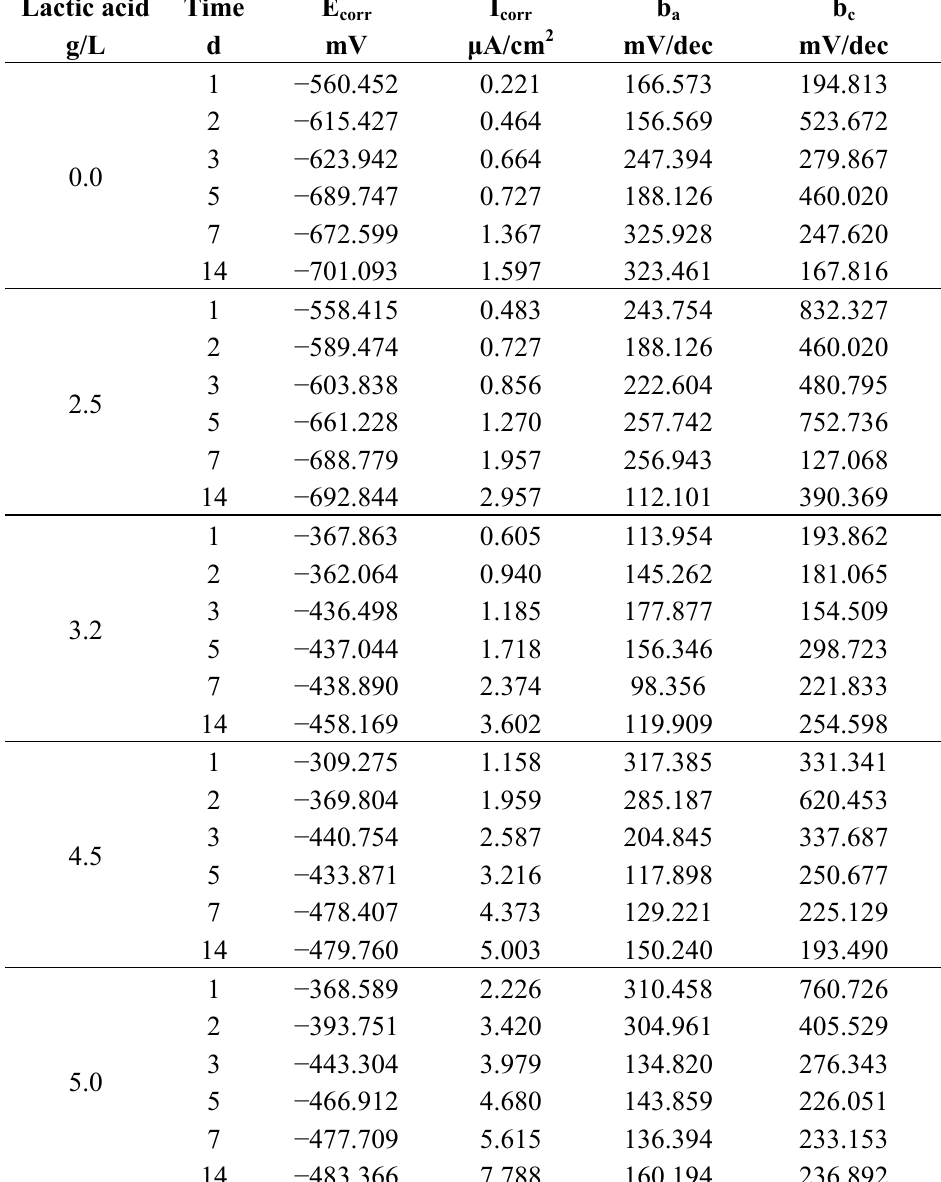
Table 2. Polarization parameters of titanium in artificial saliva containing different amounts of lactic